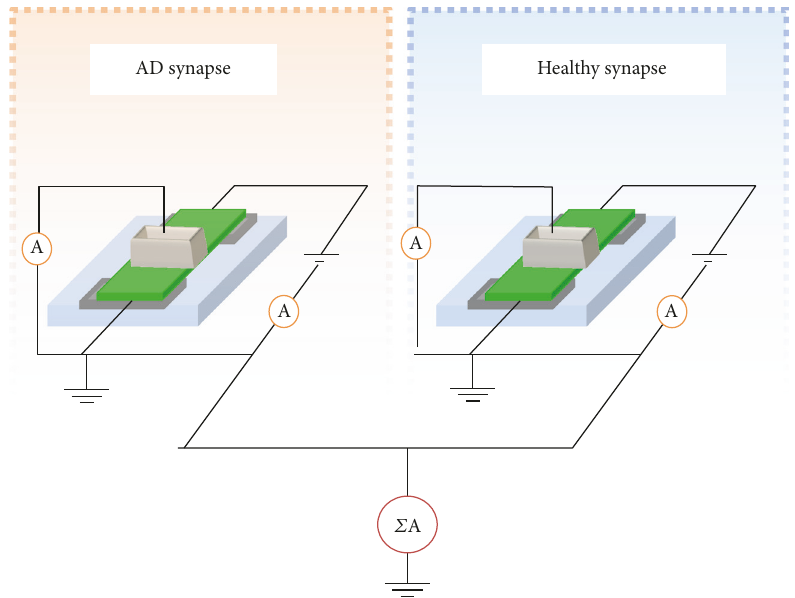
Figure 5: Scheme of the memristive